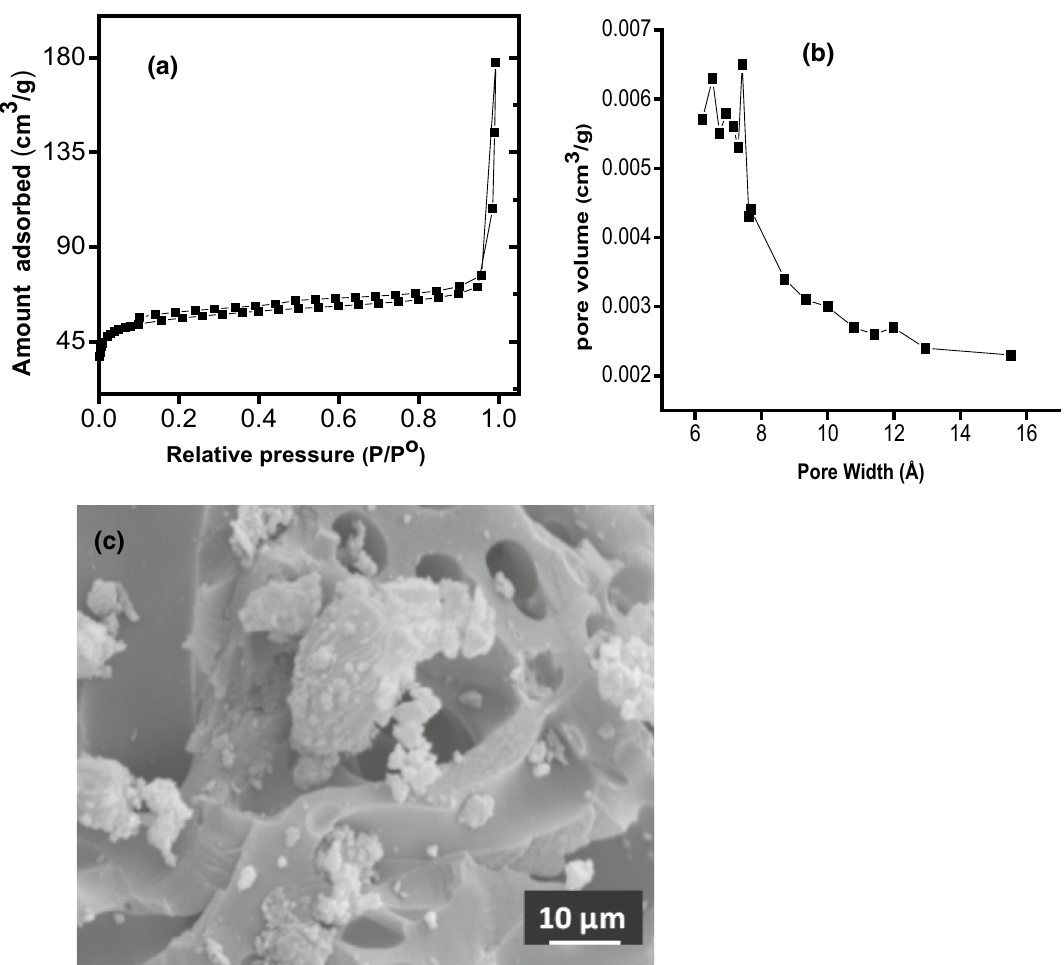
Fig. 2 a N 2 adsorption–desorption isotherm, b pore size distribution curve (PSD), c FESEM micrograph for DES/H 3 PO 4 -600